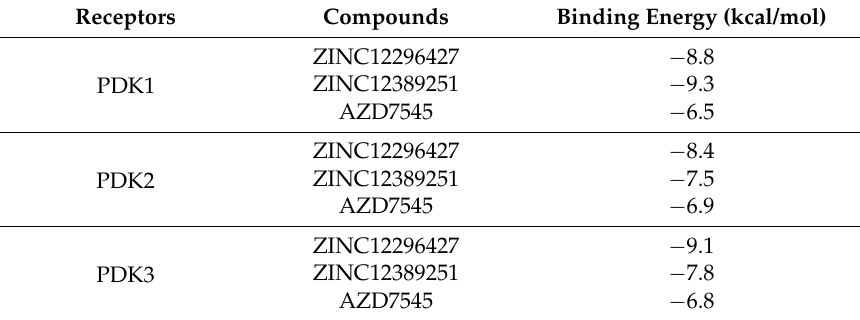
Figure 4. Superimposed structures of PDK1-docked compounds using CDOCKER (purple) and AutoDock (blue). ( a ) ZINC12296427; ( b ) ZINC12389251; ( c ) AZD7545. The surface of lipoamide binding pocket of PDK1 are shown in grey. Table 7. Binding energy of compounds with PDKs predicted by